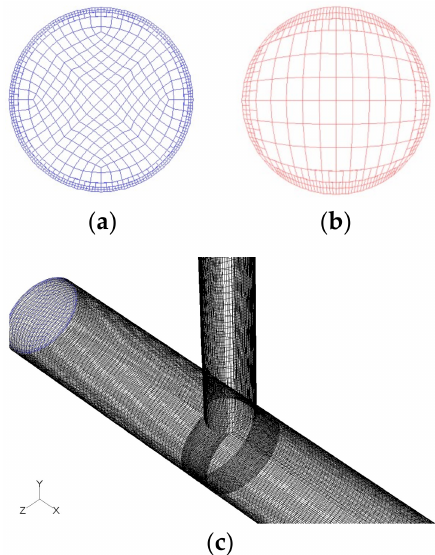
Figure 2. Computational mesh of the solar collector. ( a ) Manifold cross section; ( b ) Riser tube cross section, ( c ) Manifold and riser tube